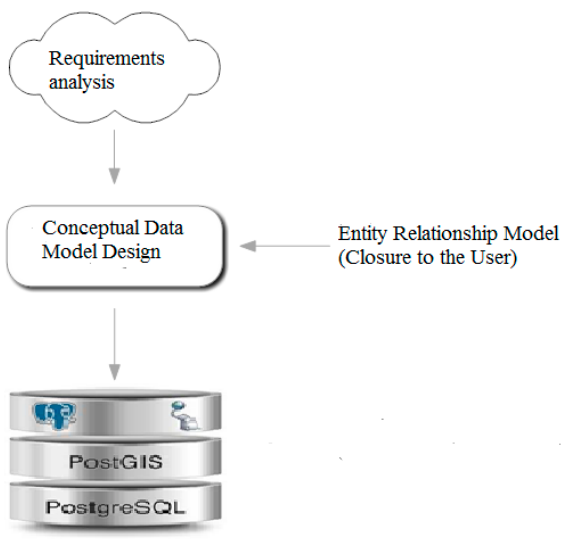
Figure 5. General Schema as Representation of Conceptual Data Model Design. Source: Own processing.